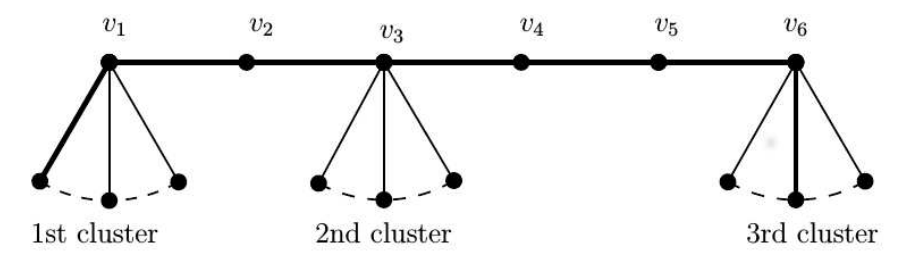
Figure 1: A centipede